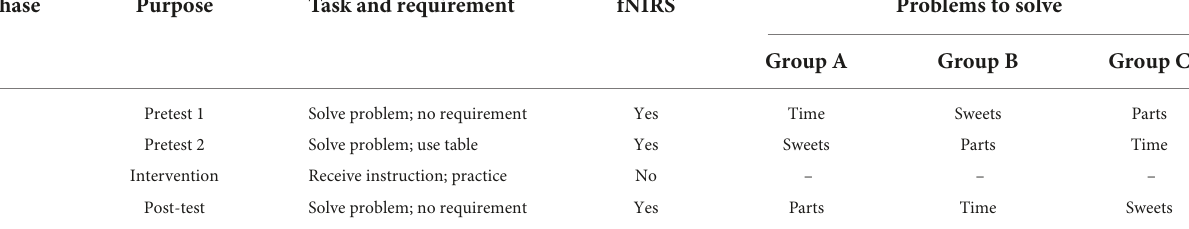
TABLE 1 Outline of the experimental design and